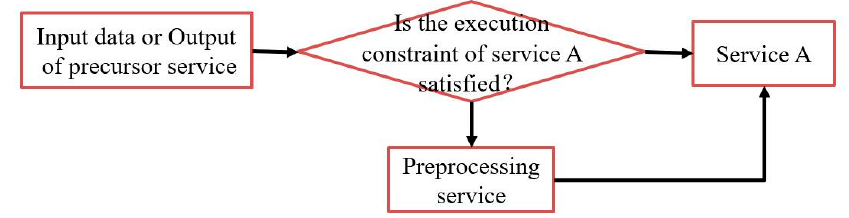
Figure 2. Preprocessing service selection to satisfy the execution constraint of service A.